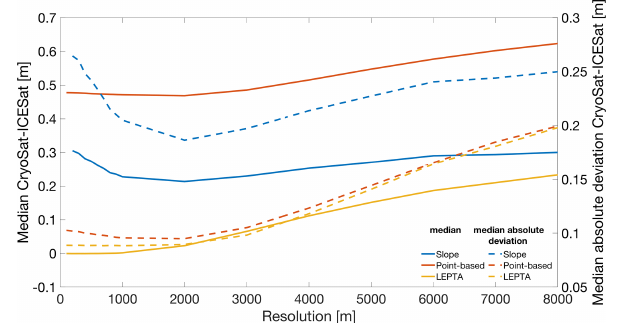
Figure 9. Median (left axis, solid curves) and median absolute de- viation (right axis, dashed curves) of height differences between CryoSat-2 and ICESat-2 ( (cid:49)h calculated with Eq. 16) as a func- tion of DEM resolution. Outliers are removed using 10th and 90th